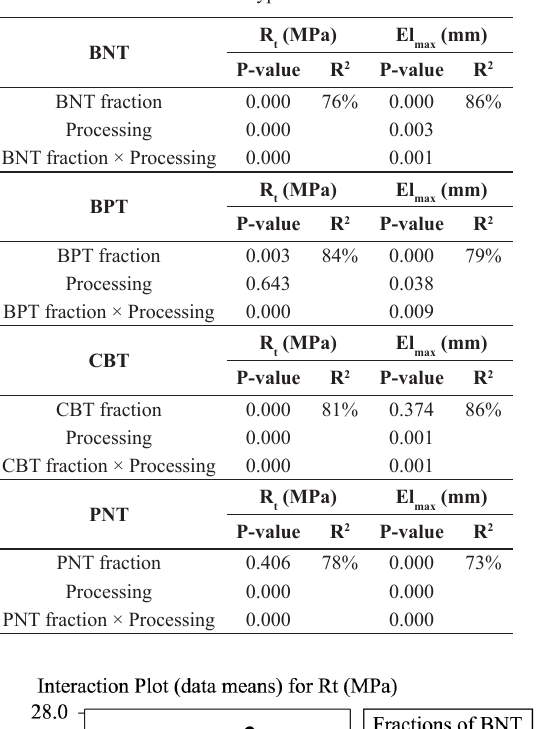
Table 3. ANOVA with different types of fibers and treatments.